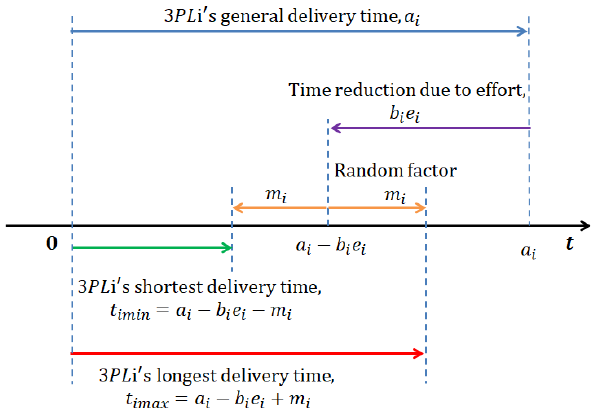
Fig. 1. 3PLi’s delivery time